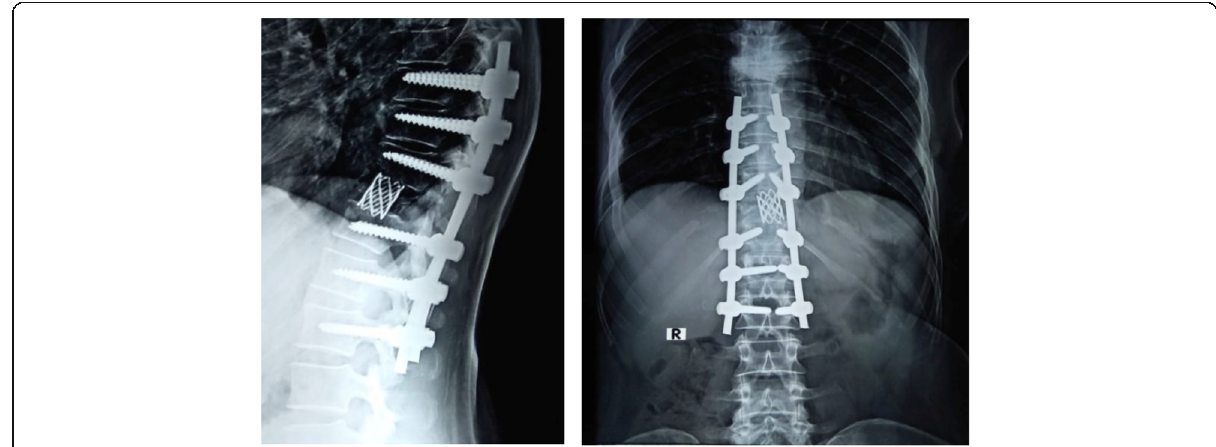
Fig. 6 Six months of postoperative X-ray